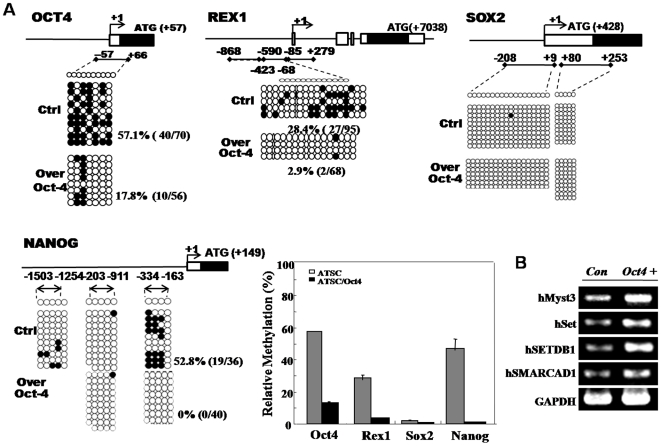
Evaluation of epigenetic modifications through methylation analysis of the promoters regions of Oct4, Rex1, Sox2, and Nanog genes.(A) Evaluation of epigenetic modifications through methylation analysis on promoter regions of Oct4, Sox2, Rex1, and Nanog through bisulfite modification and sequencing of genomic DNA. The related method was explained in supplementary materials and methods section. (B) Differential expression pattern of epigenetic reprogramming related genes such as hMyst3, hSET, hSETDB 1, and hSMARCAD 1 before and after Oct4 overexpression was detected by RT-PCR.